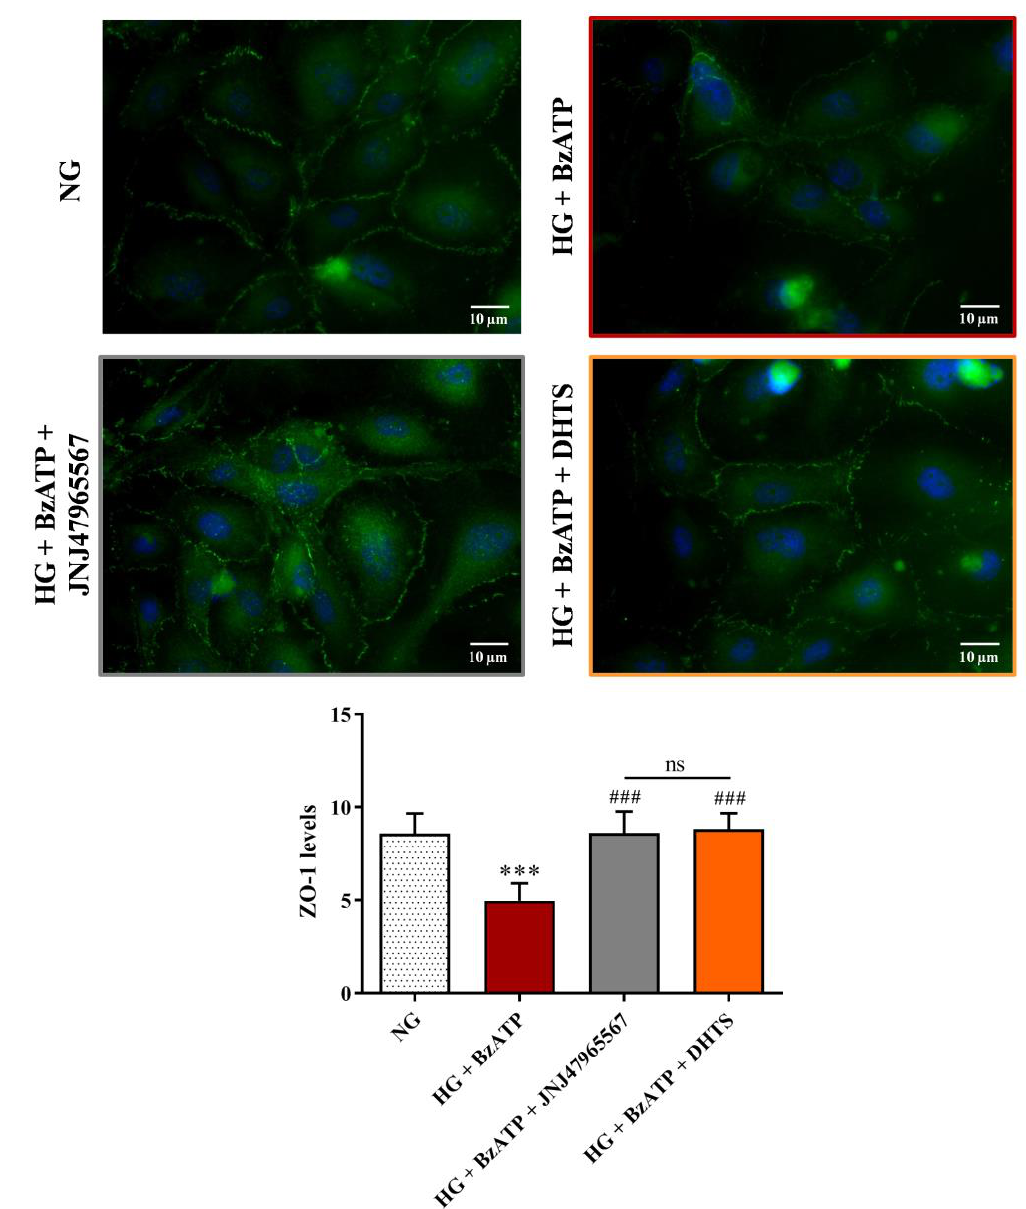
Figure 4. Immunocytochemistry evaluation of ZO-1 staining in endothelial cells subjected to normal or high glucose conditions + BzATP, in the absence or in the presence of JNJ47965567 or DHTS, for 48 h. ZO-1 was labeled with FITC (green) while nuclei were labeled with DAPI (blue). Images for ZO-1 immunostaining were acquired at 40 × magnification. Scale bar: 10 µ m. NG = normal glucose condition (5 mM). HG = high glucose condition (40 mM). BzATP = 200 µ M. JNJ47965567 = 100 nM. DHTS = 500 nM. The average intensity (AU) of the data from more than 30 cells per coverslip for ZO-1 under our experimental conditions are shown. Values are reported as means ± SD of three independent experiments. Statistical analysis was performed using one-way ANOVA with Tukey’s post-hoc analysis. *** p < 0.001 vs. NG. ### p < 0.001 vs. HG + BzATP. ns = not